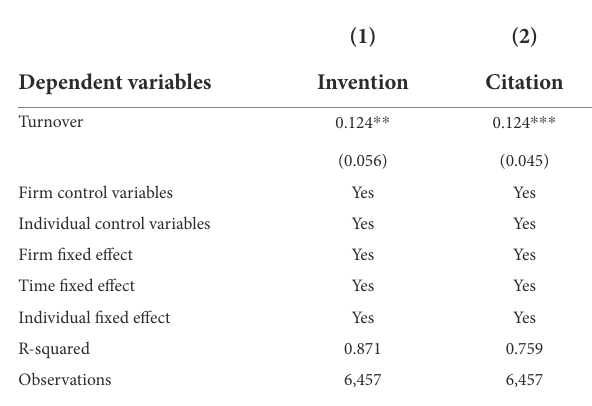
FIGURE 3 Placebo test - invention.